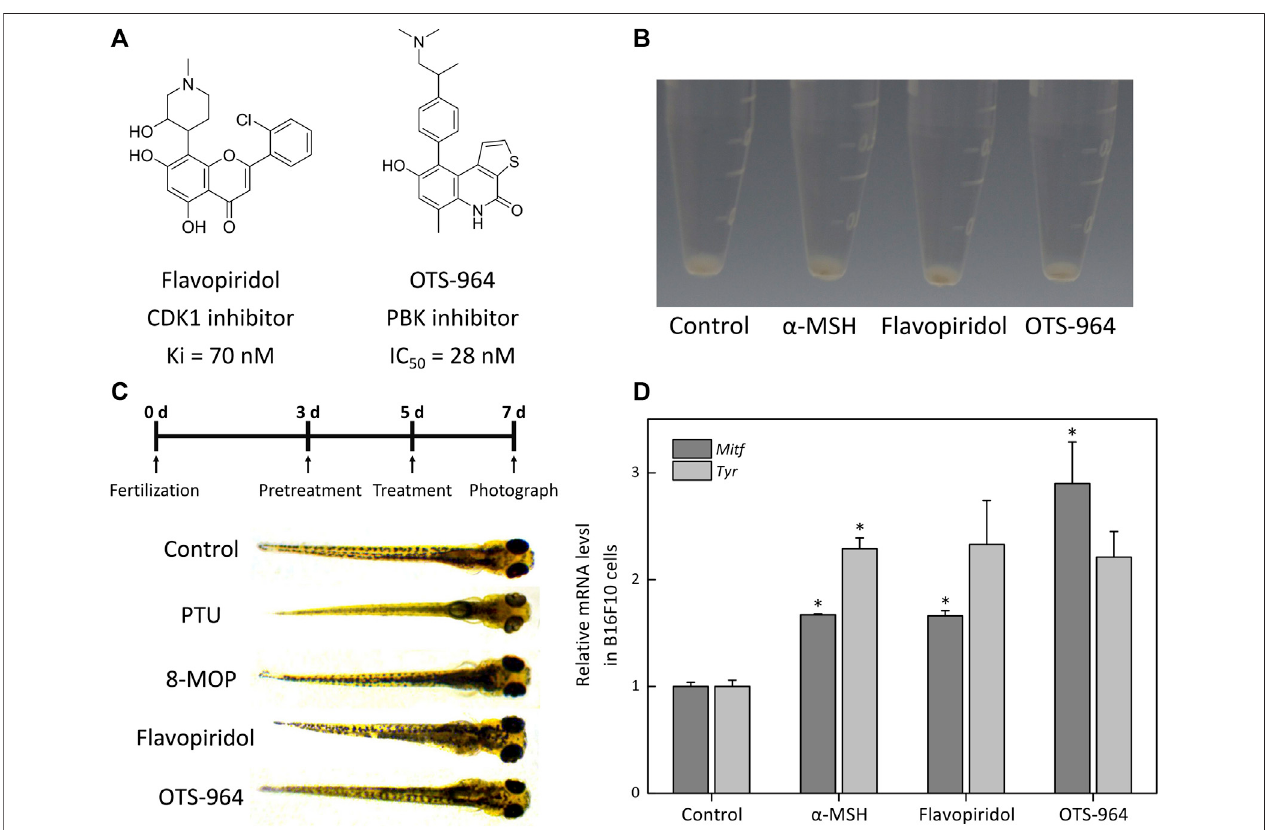
FIGURE 8 | The effect of CDK1 and PBK inhibitors on melanogenesis in B16F10 cells and zebra fi sh. (A) Schematic of the chemical structure of fl avopiridol (CDK1 inhibitor) and OTS-964 (PBK inhibitor). (B) Cells were treated with α -MSH (10 nM), fl avopiridol (10 nM) and OTS-964 (10 nM) for 48 h. Cell pellets and cellular pigmentation were photographed using the PENTAX K-7. The α -MSH is a regulator of melanocyte differentiation and melanogenesis by binding to the MC1R on melanocytes. (C) The experimental design of the zebra fi sh model. Zebra fi sh embryos were pretreated with phenylthiourea (PTU; 200 μ M) for 48 hpf. Then, these embryos were treated with methoxsalen (8-MOP; 100 μ M), fl avopiridol (10 nM) and OTS-964 (10 nM) for 48 hpf. PTU was used as a negative control and 8-MOP was used to a positive control. The pigmentation of the embryos was observed under a stereomicroscope. (D) The expressions of melanin-biosynthetic genes ( Tyr and Mitf ) mRNA were measured by qPCR assay. The B16F10 cells were incubated with fl avopiridol (10 nM) and OTS-964 (10 nM) for 48 h.